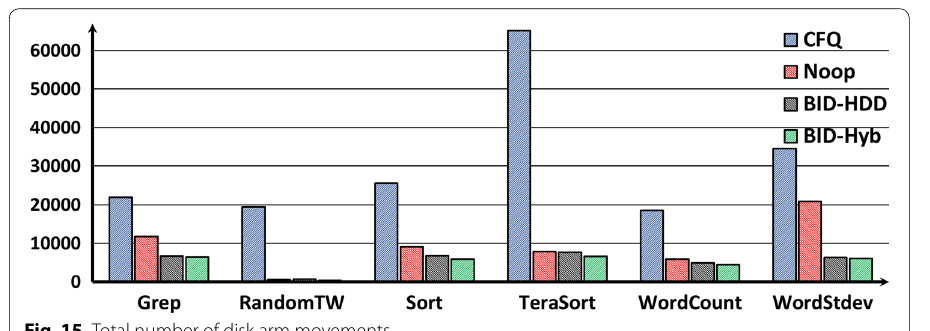
Fig. 15 Total number of disk arm